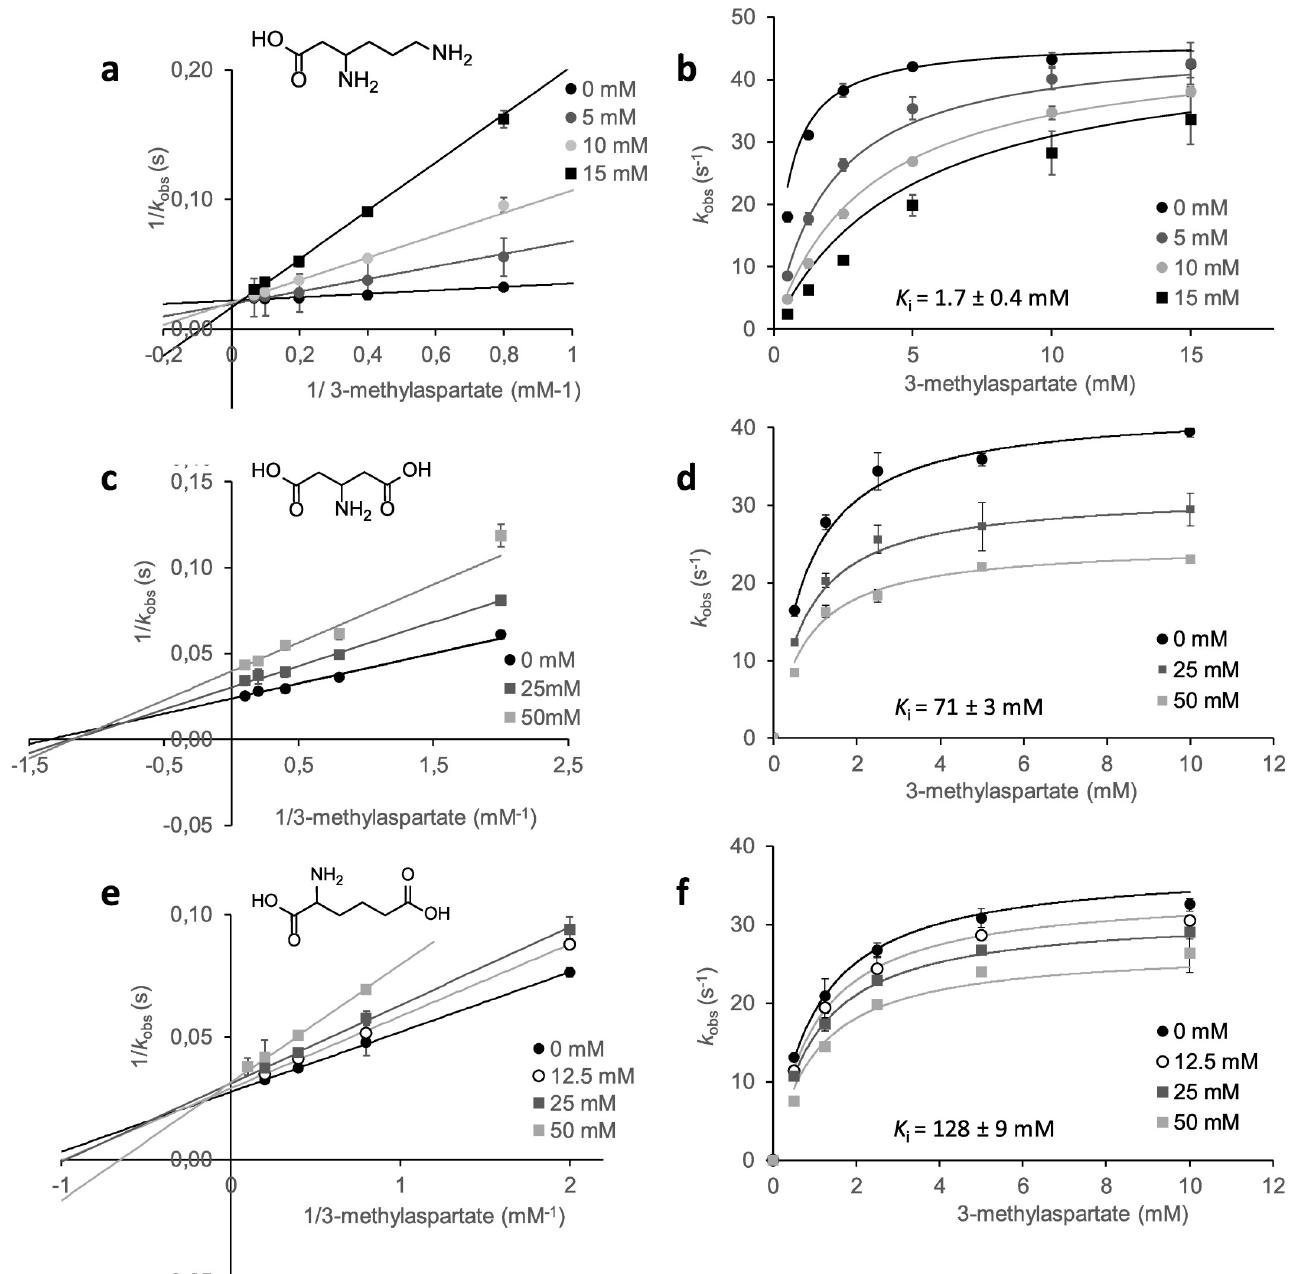
Fig 4. Inhibition assays. Lineweaver-Burk plots of 3-methylaspartate deamination by CaMAL in the presence of different concentrations of β -lysine (a), β - glutamic acid (c) and 2AAA (e). Plots of 3-methylaspartate deamination by CaMAL in the presence of different concentrations of β -lysine (b), β -glutamic acid (d) and 2AAA (f) and fitting to a non-linear regression function (competitive inhibition function following the equation y = k cat x / K m (1 + I c / K i ) + x or noncompetitive inhibition function following the equation y = k cat x / (1 + I c / K i ) ( K m + x)). β -lysine data fitted to the competitive inhibition function (Global R 2 = 0.998), β -glutamic acid data fitted to the non-competitive inhibition function (Global R 2 = 0.995), and 2-aminoadipic acid data fitted to the non-competitive inhibition function (Global R 2 = 0.997). Inhibition constants ( K i ) of CaMAL obtained for the three inhibitors are shown. Data are the means of three replicates with 95% confidence